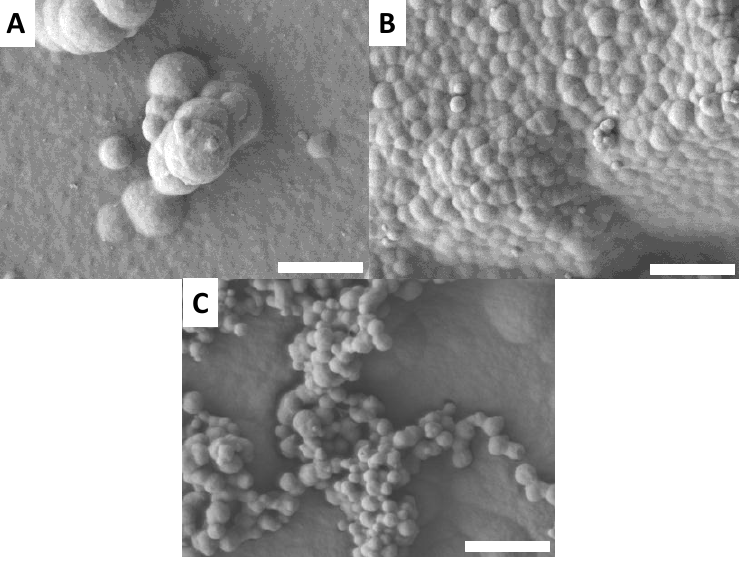
Figure 7. Morphologies observed for surfaces developed using ante strategy (scale bar = 1 μm). ( A ) PEDOT-Thym-F 4 three scans; ( B ) PEDOT-Thym-F 6 three scans; ( C ) PEDOT-Thym-F 8 three scans.